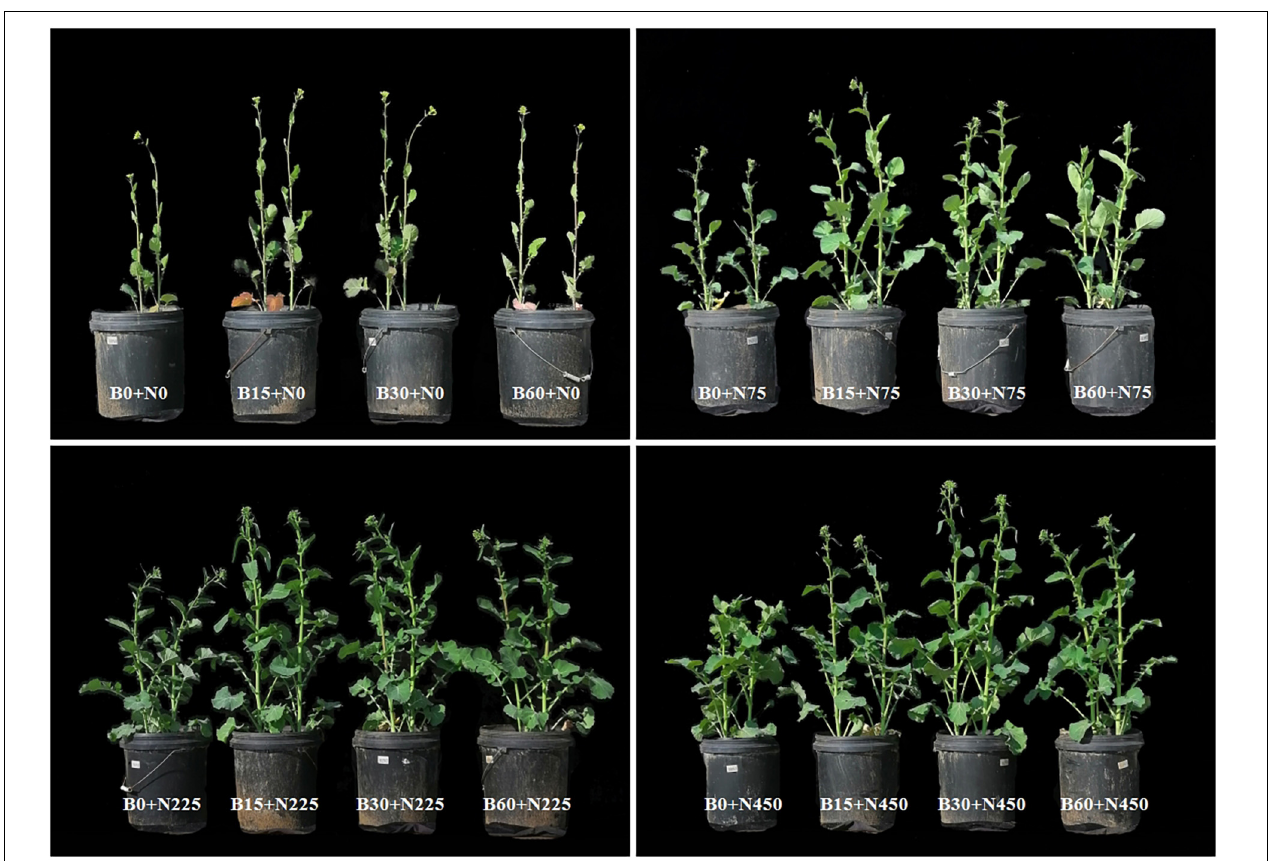
FIGURE 8 | Rapeseed phenotypes representing each treatment combination of biochar and